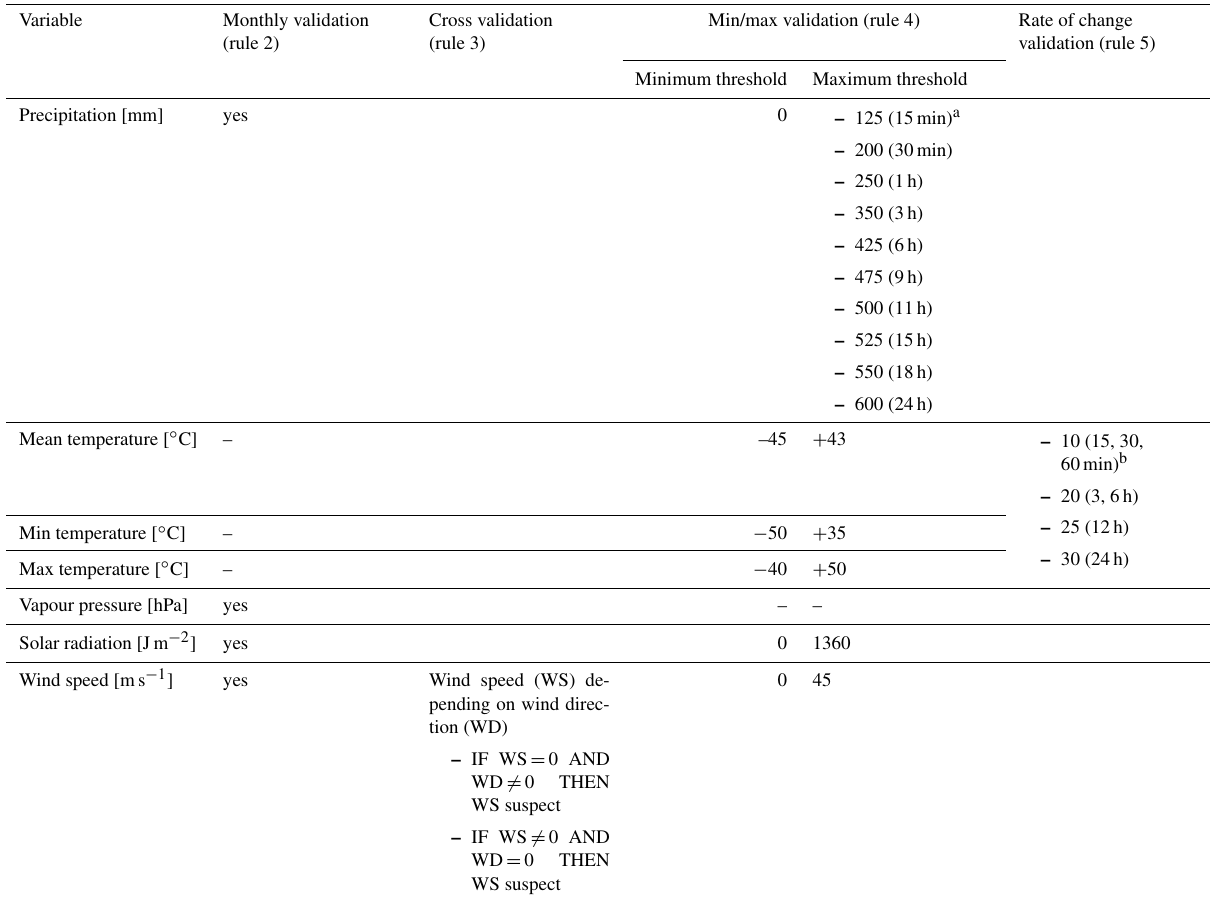
Table 3. Specifications for the validation rules as applied to the EMO-5 source